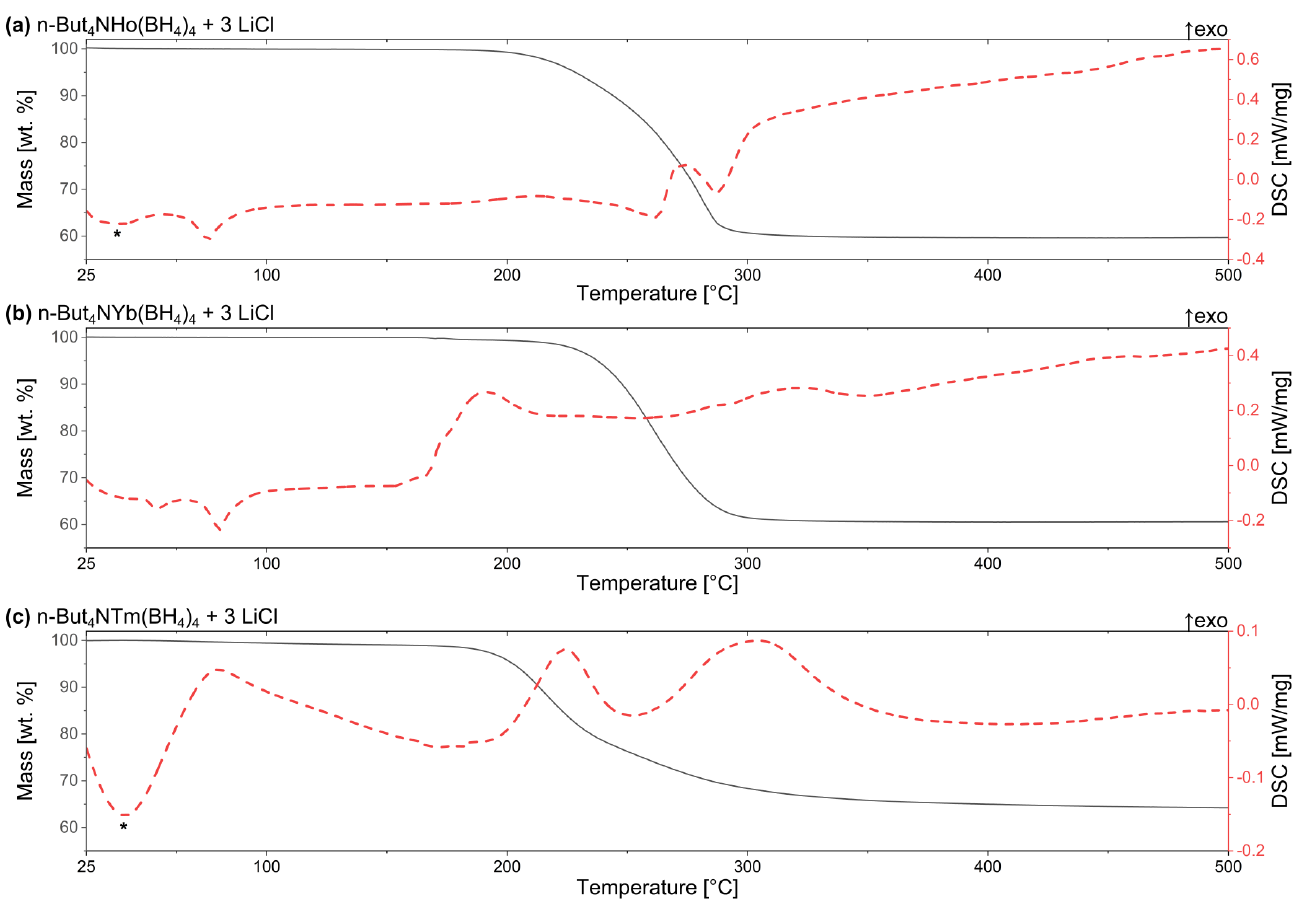
2 Figure 3. TGA/DSC curves of the crude, not purified samples ( a ) Ho , ( b ) Yb, and ( c ) Tm , prepared as in Table 1. *—artifact,